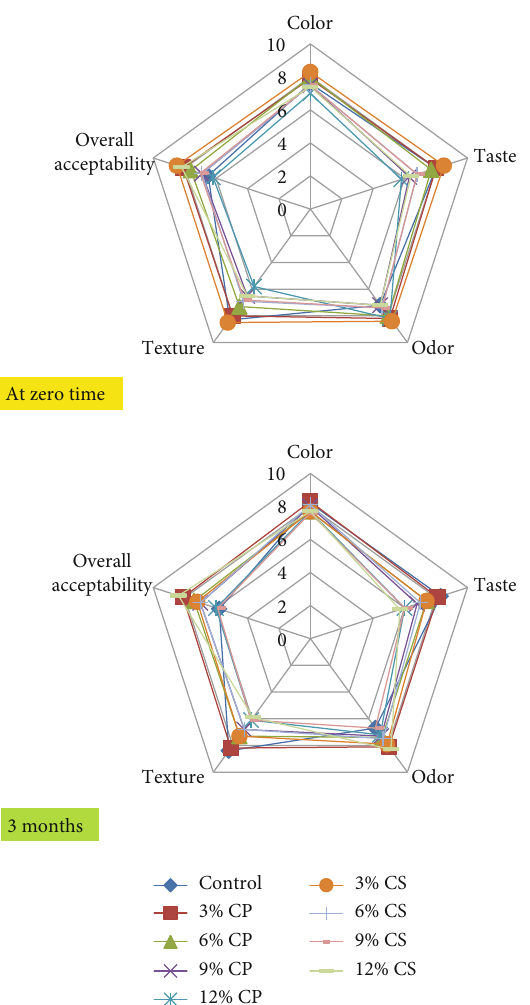
Figure 5: Changes in sensory evaluation of chicken patties supplemented with cantaloupe peel (CP) and seeds (CS) powder during storage at -20 for 3